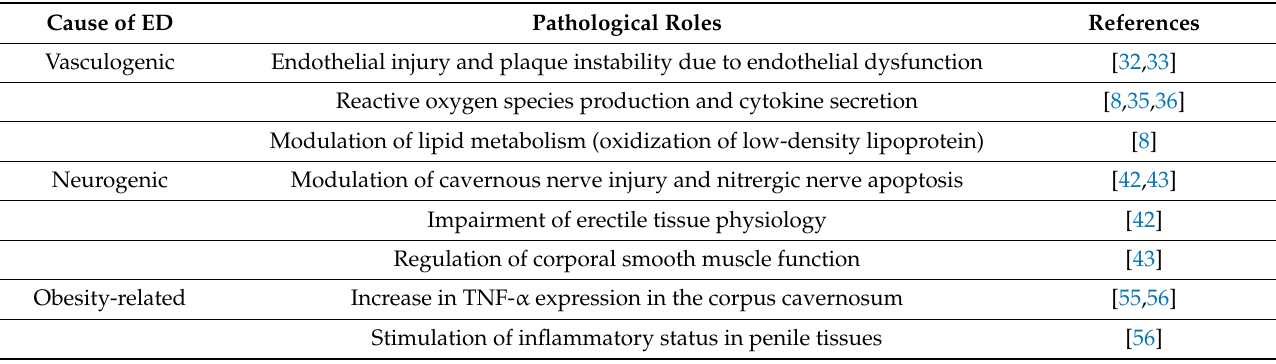
Table 1. Summary of pathological roles of macrophages in erectile dysfunction. Cause of ED Pathological Roles